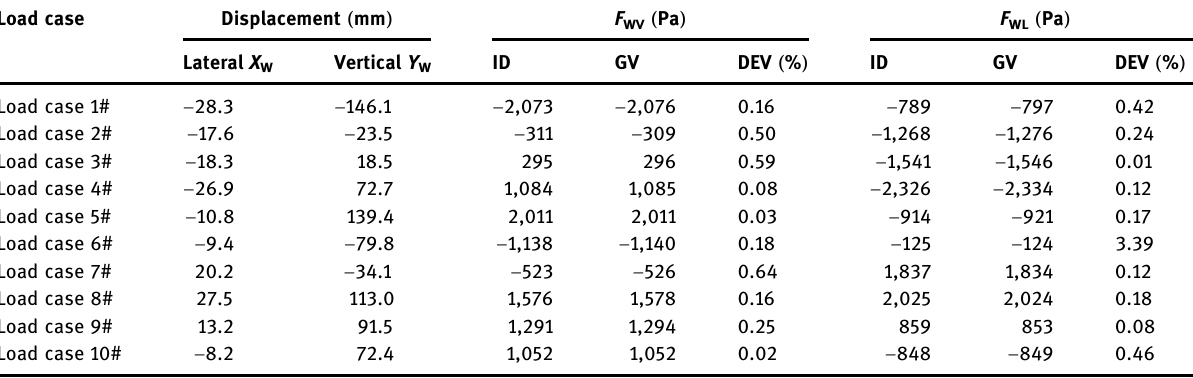
Table 4: Comparison between identified and given results in validation simulation Load case